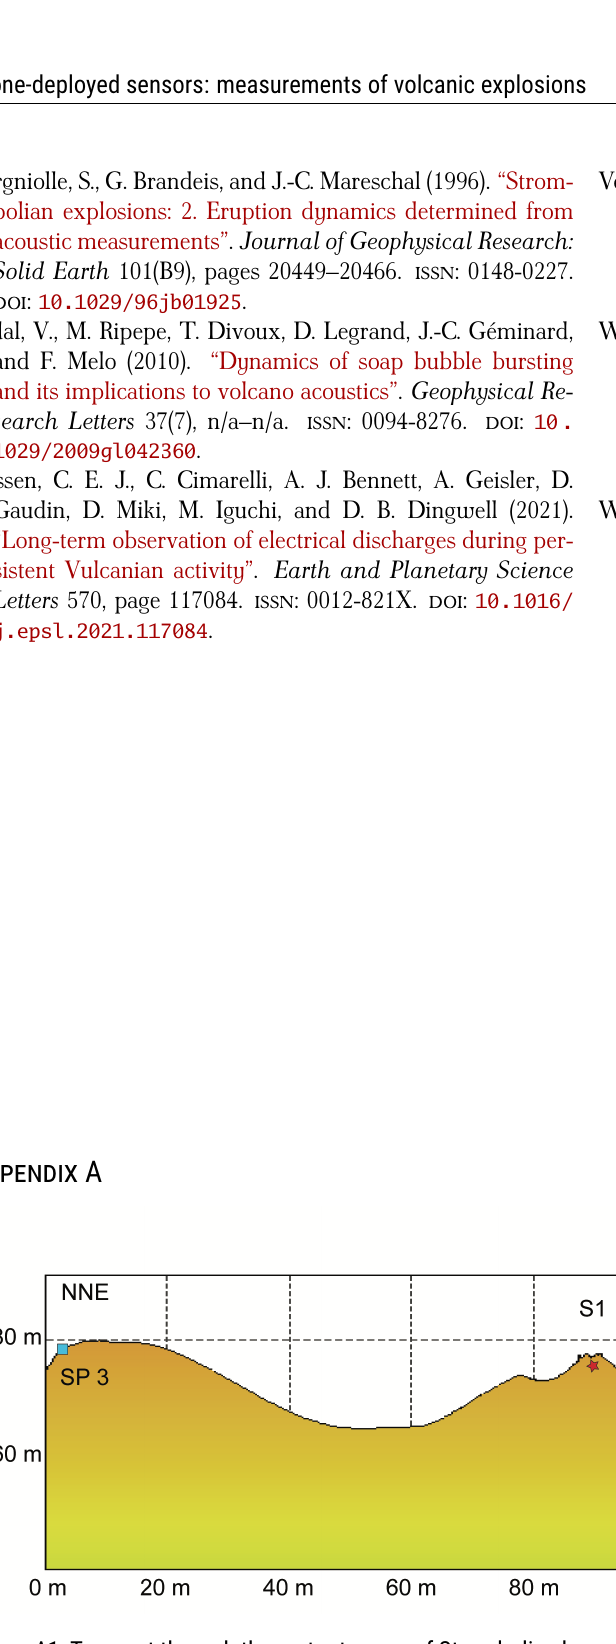
Figure A1: Transect through the crater terrace of Stromboli volcano, Italy. The transect starts in the NNE, close to the location of SP3, and continues through vent S1 and S2 towards the SSW close to the location of SP1 (Figure 2). The transect was created from a digital elevation model (DEM) of the crater terrace at the time of the field campaign. Refer to Schmid et al. [2021] for a description of the DEM